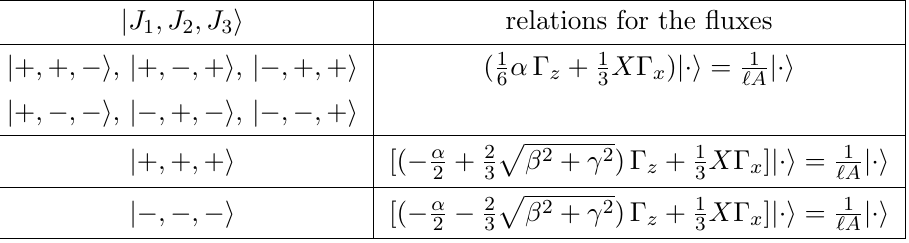
Table 5 . Decomposition of (4.29) KSE into